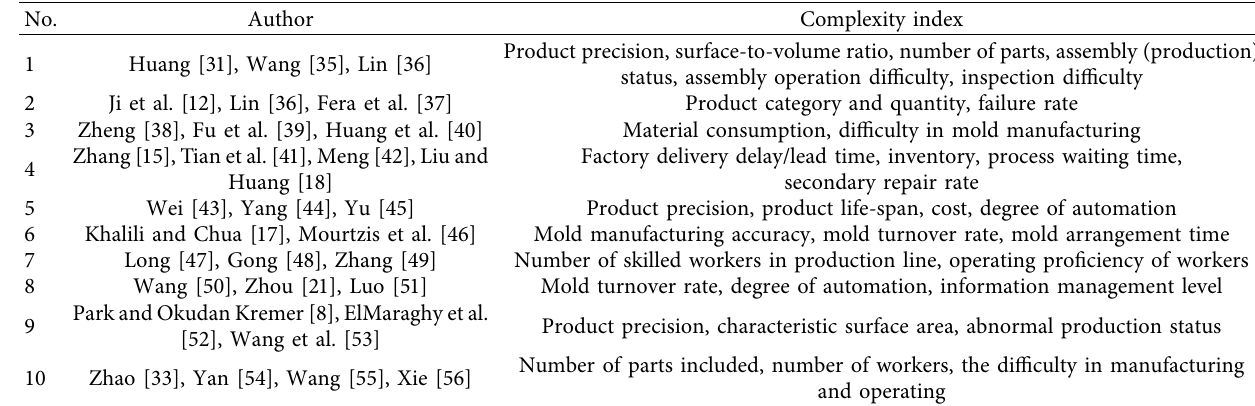
Table 1: Product complexity indices from literature